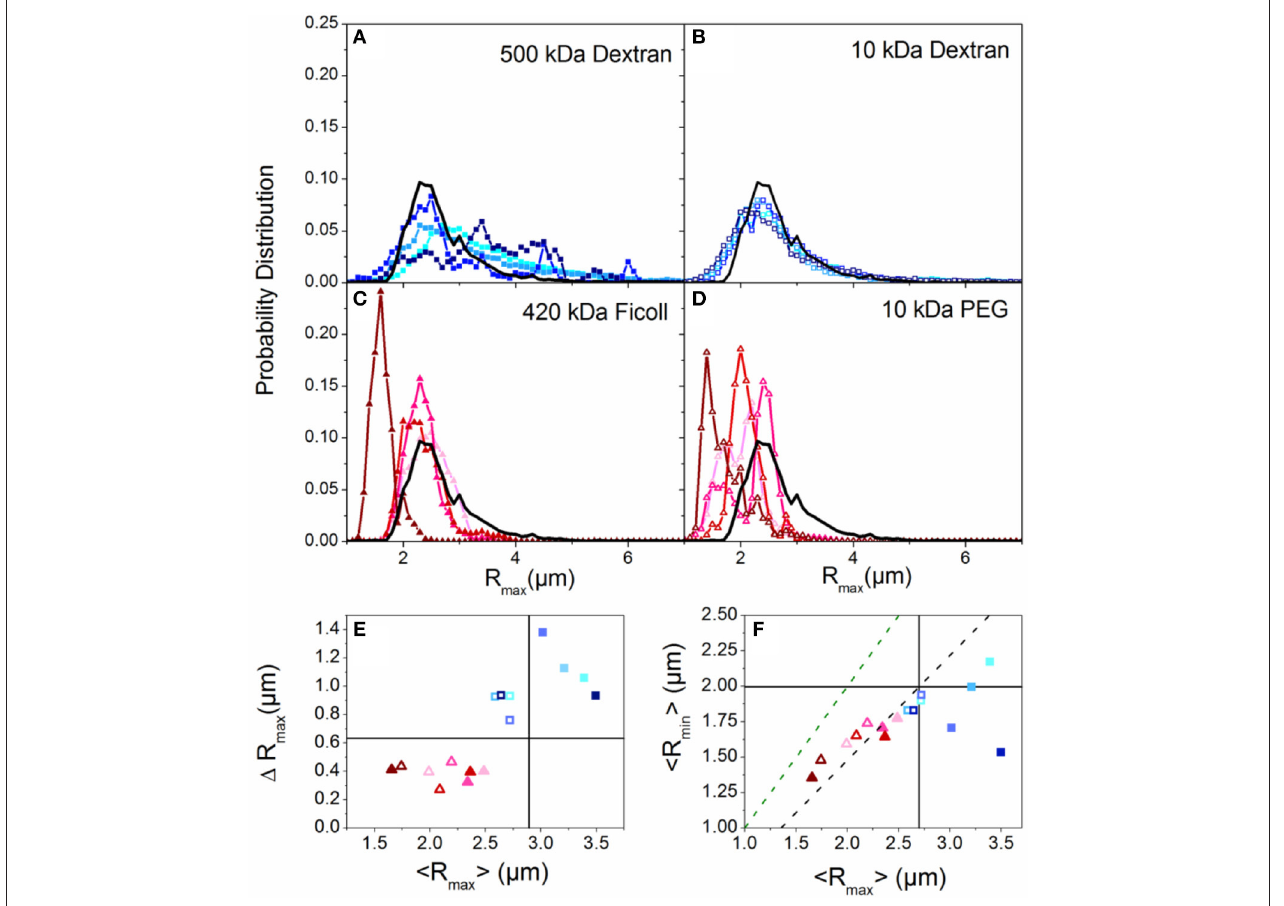
FIGURE 1 | Crowding induces compaction or elongation of DNA dependent on the crowder structure. (A–D) Histograms of major axis lengths ( R max ) for all crowding conditions compared to the buffer condition (black line). Each panel displays results for a different crowder with blue hues denoting linear crowders ( A,B ; dextrans) and red hues indicating branched crowders ( C,D ; Ficoll, PEG). Closed symbols indicate high M w crowders ( A,C ; 500 kDa dextran, 420 kDa Ficoll) and open symbols denote low M w crowders ( B,D ; 10 kDa dextran, 10 kDa PEG). In each panel the color shade increases with increasing crowder concentration (10, 20, 30, 40% w/v). (E) The standard deviation of each R max distribution, 1 R max , vs. the corresponding mean, < R max > . The color scheme is the same as (A–D) . The buffer condition (0% crowder) value is indicated by the intersection of the horizontal and vertical lines. Symbols above or below the horizontal line indicate increased or decreased ranges in conformational states accessed, and symbols to the left or right of the vertical line indicate crowding-induced compaction or elongation. (F) Phase plot of the mean major and minor axis lengths ( < R max > , < R min > ) for each crowded condition. The green dashed line denotes the < R max > : < R min > ratio for a spherical particle. The black dashed line denotes < R max > : < R min > for the empirically measured random coil configuration in aqueous buffer. Note that branched crowders (triangles) generally decrease < R max > and < R max > : < R min > indicating more spherical compacted conformations, while linear crowders (squares) tend to elongate